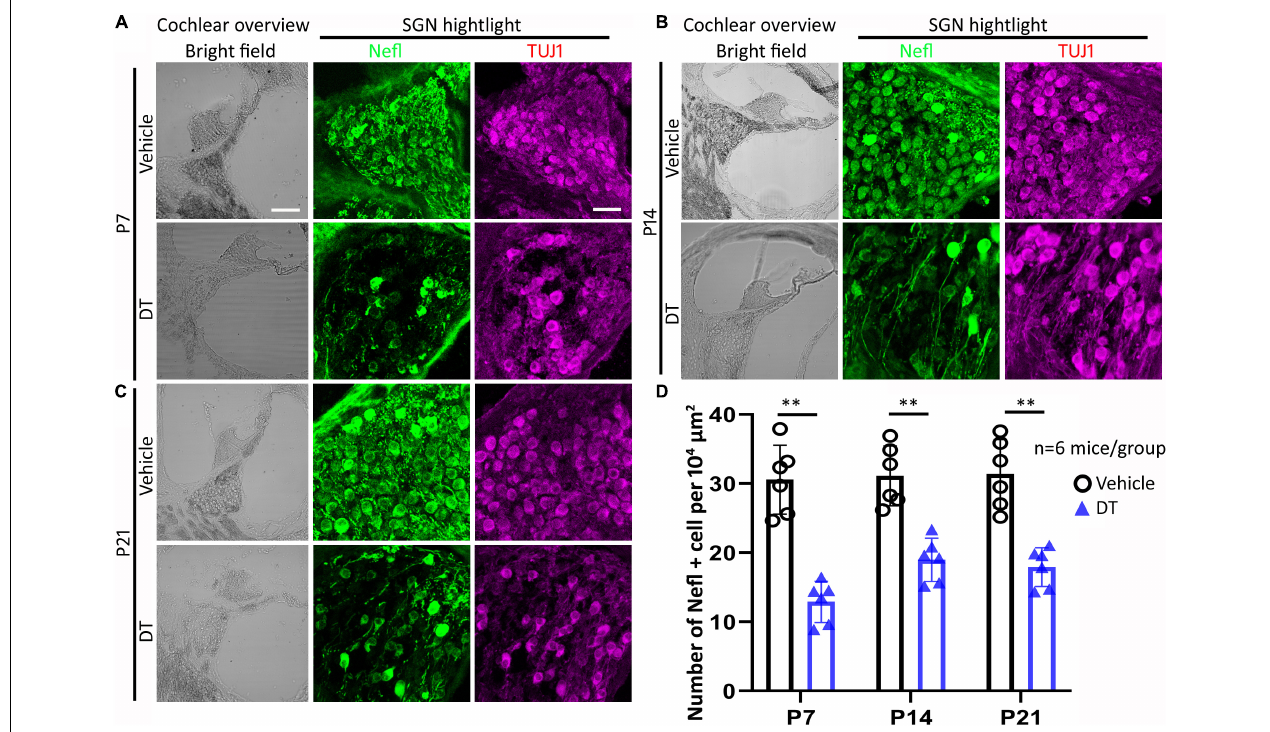
FIGURE 4 | Spiral ganglion neuron (SGN) study of Nefl CreER / + ;iDTR + / − mice. Nefl CreER / + ;iDTR + / − mice were treated with tamoxifen, followed by diphtheria toxin (DT) or vehicle treatment on P7 (A) , P14 (B) , and P21 (C) . Nefl and TUJ1 immunofluorescence was used to identify SGNs. In the quantitative study (D) , significantly decreased numbers of Nefl-expressing SGNs were observed in the DT treatment groups, including the P7, P14, and P21 groups. ∗∗ p < 0.01 (ANOVA, n = 6 mice per group). Scale , 100 µ m in cochlear overview and 25 µ m in SGN highlight.